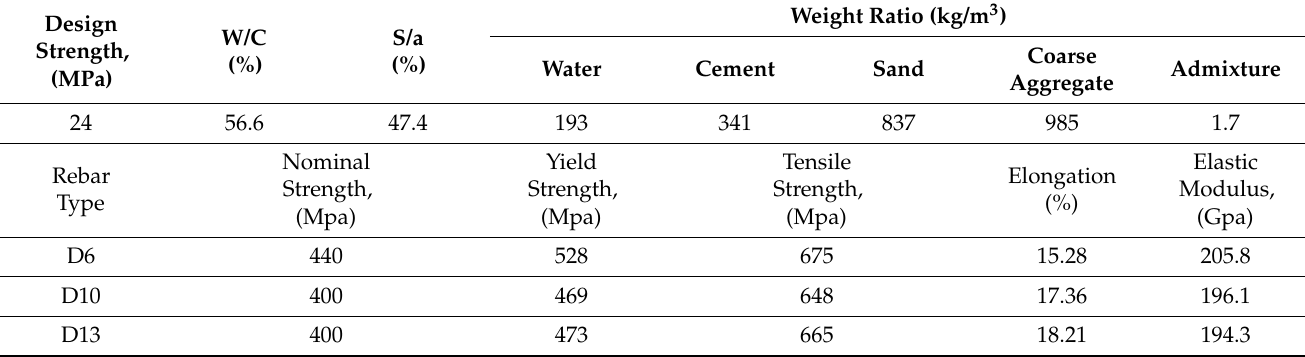
Table 6. Mix proportion of concrete and material test results of